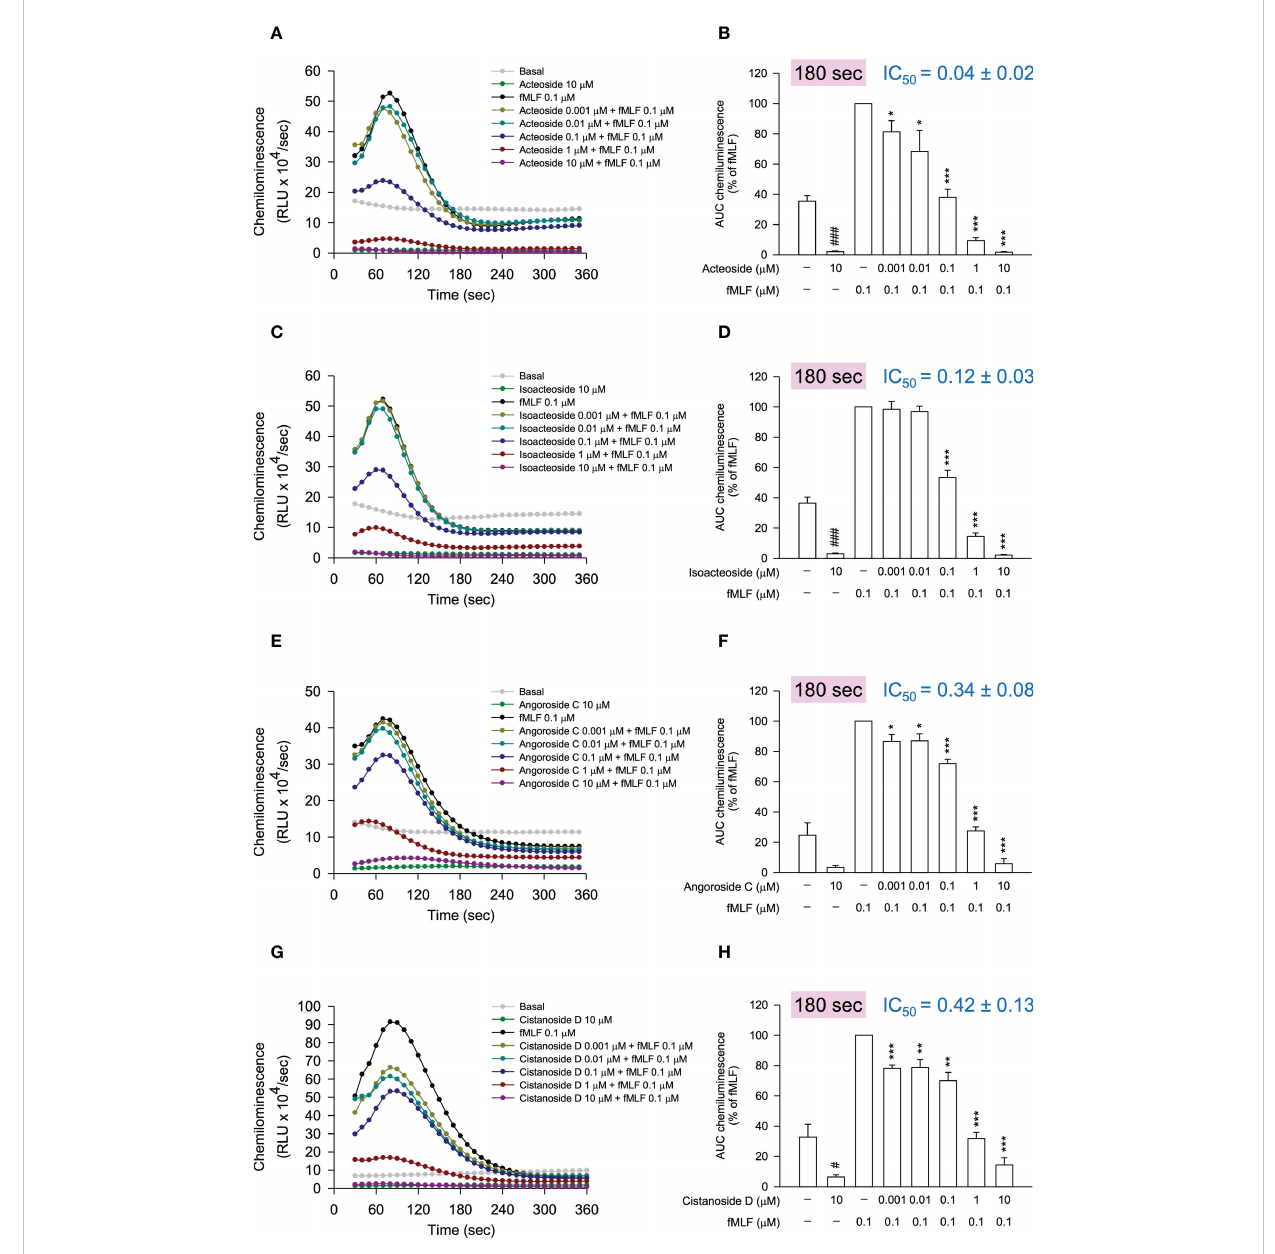
FIGURE 6 The compounds from the bioactive MIMN clusters inhibited the N -formyl methionyl-leucyl-phenylalanine (fMLF)-induced reactive oxygen species (ROS) generation in human neutrophils. (A, C, E, G) The luminol-mixed human neutrophils were incubated with DMSO (0.1%, as control) or compounds (0.001 – 10 m M) and were activated by fMLF (0.1 m M). ROS production was detected by a chemiluminometer. The area under the curve (AUC) value was quanti fi ed and shown in (B, D, F, H) . The values were shown as the mean ± S.E.M. (n = 3 – 4). # p < 0.05, ### p < 0.001 compared with the non-stimulated control; * p < 0.05, ** p < 0.01, *** p < 0.001 compared with the stimulated